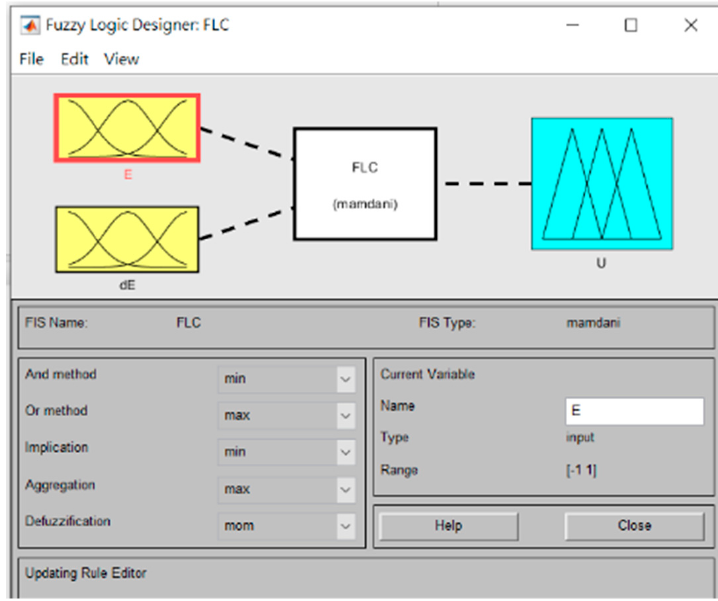
Figure 8. Fuzzy inference block.